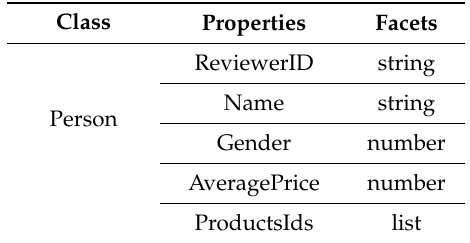
Table 1. Classes, properties and facets of